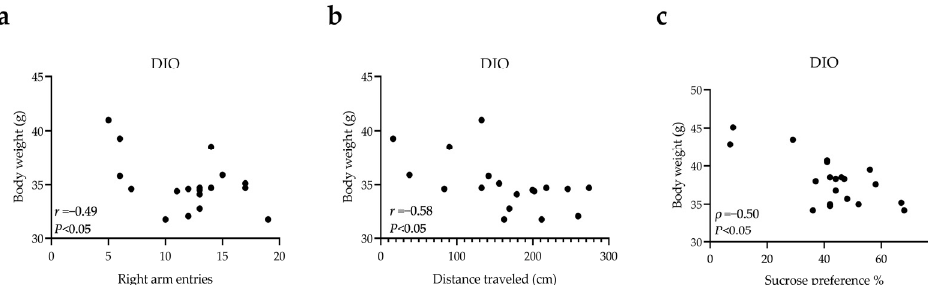
Figure 6. The body weight of DIO mice was negatively correlated with the right arm entries ( a ) or distance traveled in the central zone ( b ) or sucrose preference percentage ( c ). Compared with CD group, nNOS protein levels in both the hippocampus ( t = − 4.09, df = 9, p < 0.05) and prefrontal cortex ( t = − 4.57, df = 9, p < 0.05) increased significantly in the DIO group (Figure